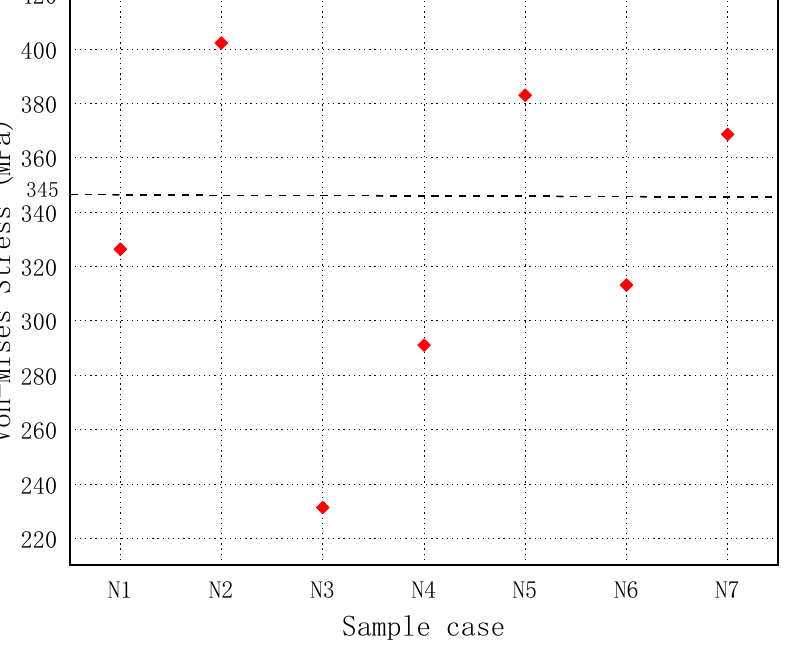
Figure 20. Maximum von Mises stress of the guardrail.